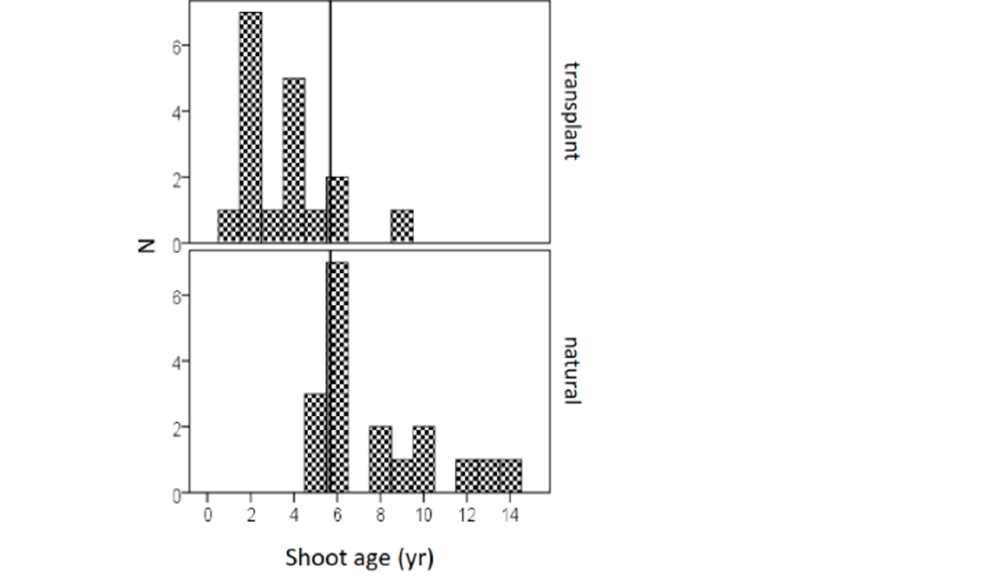
Figure 7. Mean values (SE) of speed of growth ( a ), primary production ( c ) across lepidochronolog- ical years and shoot age ( b , d ).